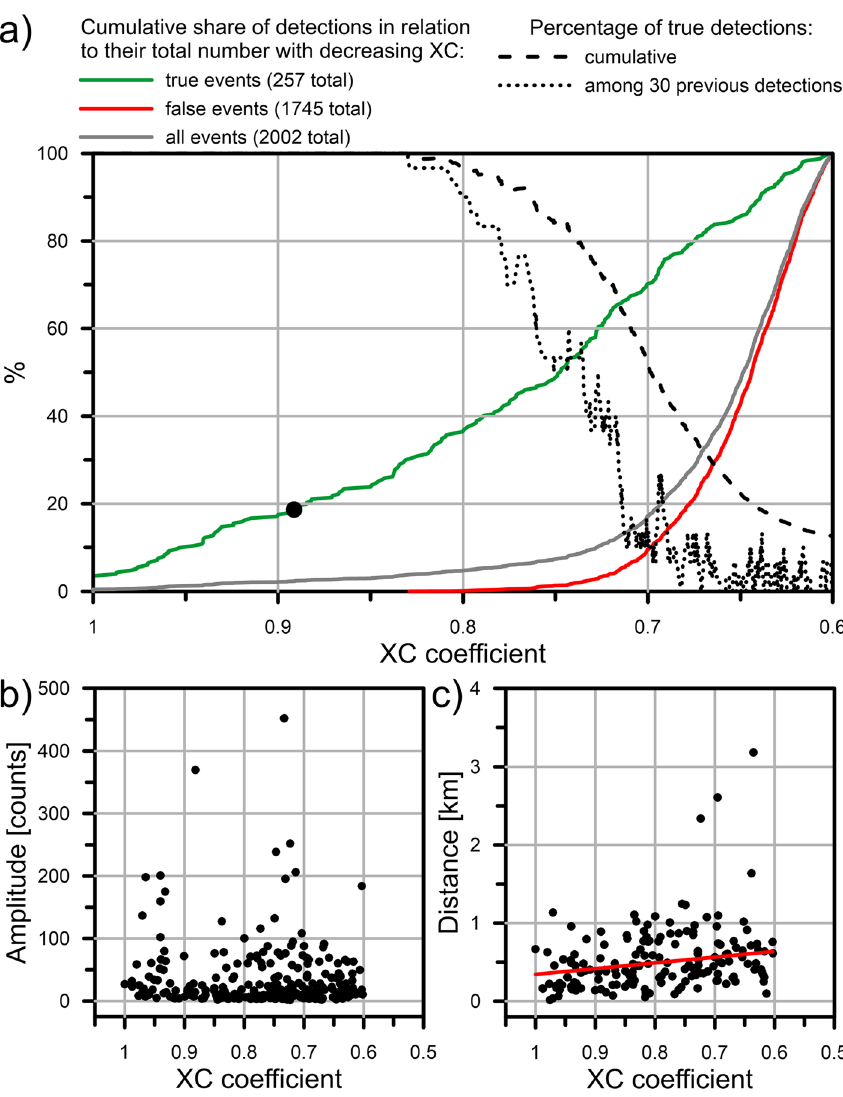
Figure 2. ( a ) Solid lines: share of detections in relation to their total number for XC thresholds between 1 and 0.6. for groups including all the 2002 detections (grey line), the 257 true detections only (green line) and the 1745 false detections only (red line). Dashed black line: share of true detections for all detections with XC > a given threshold value. Dotted black line: share of true detections within group of consecutive 30 detections with the value of XC ≥ a given threshold value. Black dot indicates the share of detections obtained with STA/LTA technique in relation to amount of true events detected with cross-correlation. ( b ) Amplitudes of the detected true events as a function of XC coefficient (highest value of XC is considered if more than 1 master detected a given event). ( c ) Epicentral distance between located events of the cluster and the master with the highest value of the XC coefficient against the XC value. The red line represents the linear regression of the distribution obtained by neglecting the 4 farthest